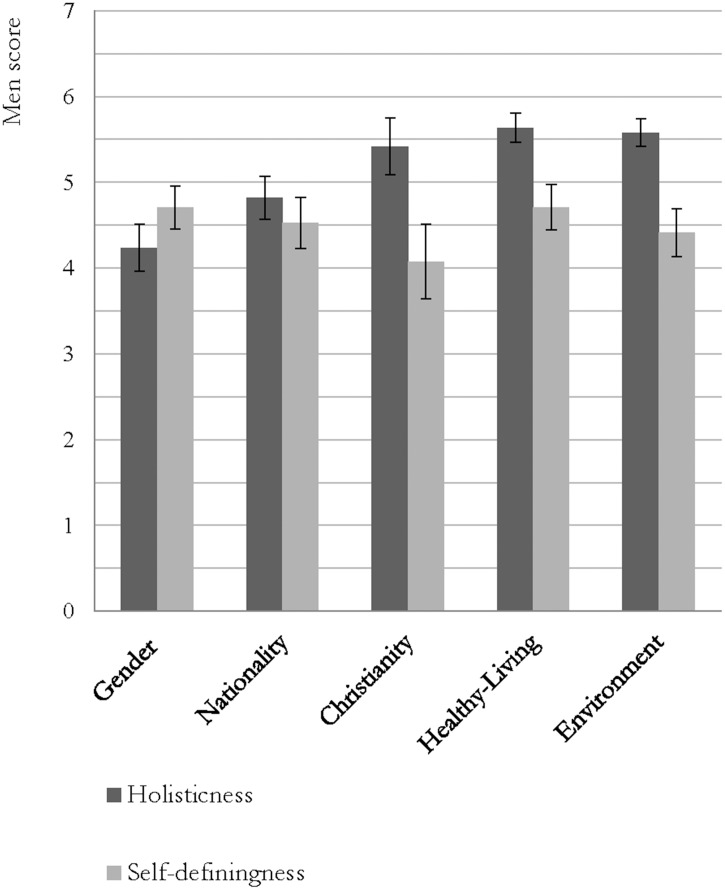
Mean perceived holisticness and self-definingness of Gender, Nationality, Christianity, Healthy-Living and Environment.